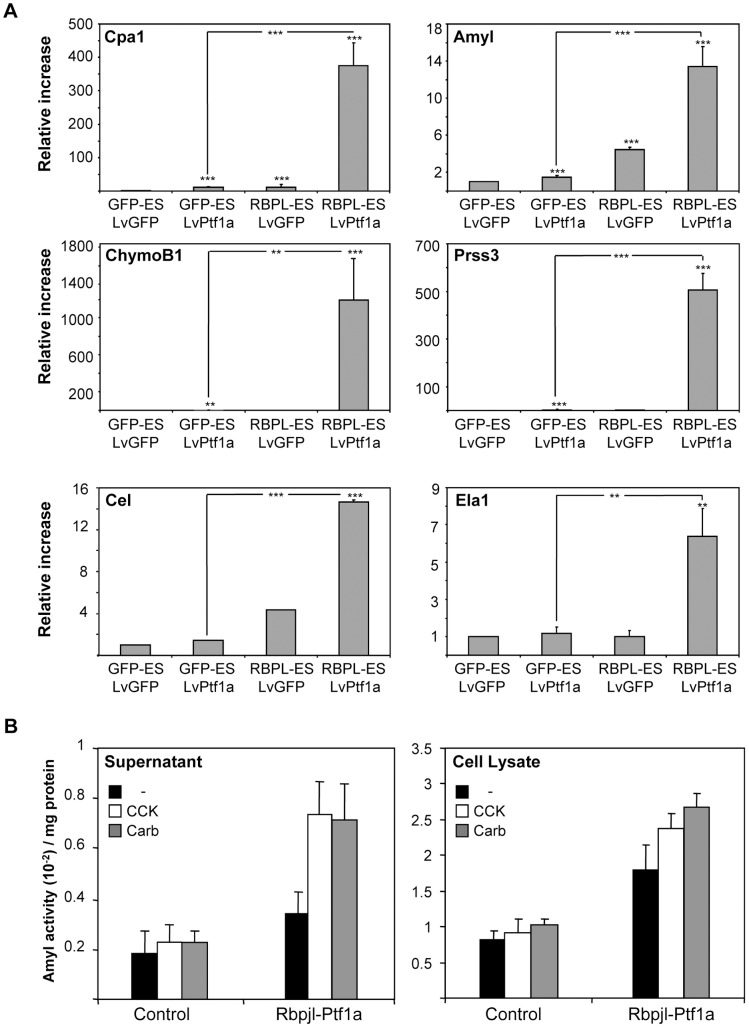
Digestive enzyme gene expression in transgenic GFP-ES and RBPL-ES differentiated throughout the whole protocol.A) Analysis of digestive enzyme gene expression by qRT-PCR at the end of the protocol at the indicated culture conditions. T19 cultures of ESC and GFP-ES infected with LvGFP showed no significant differences in gene expression levels (not shown). Histograms show the relative expression levels normalized to the loading control Hprt. Error bars indicate the standard deviation of 2 experiments performed in triplicates. p, as compared to GFP-ES infected with LvGFP. LvPtf1a indicates in this figure LvPtf1a-ER treated with Tamox. B) Secretagogue-mediated exocytosis in differentiated cells. Control GFP-ES or RBPL-ES cells infected with LvGFP or LvPtf1a-ER, respectively, were differentiated through the whole protocol and stimulated for 30 minutes with CCK and carbachol. Amylase activity was measured in both the supernatant and cell lysates.